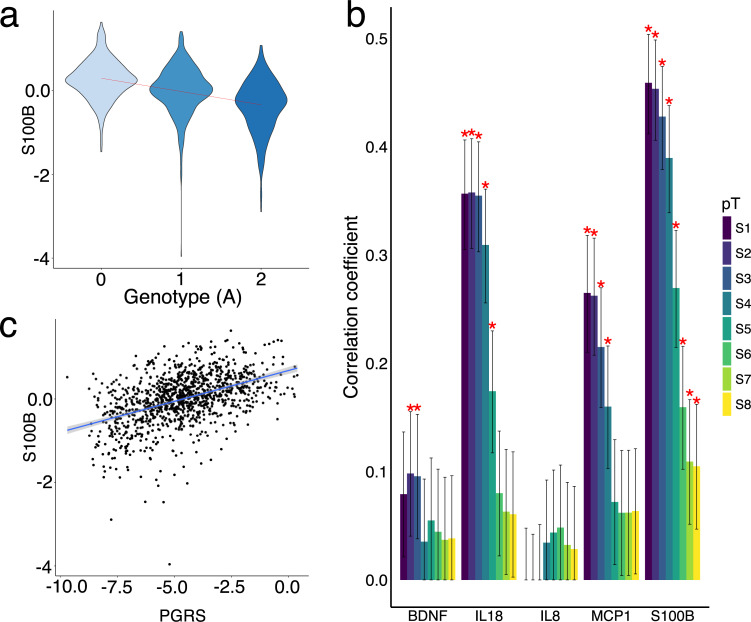
Prediction of inflammation marker levels by genetic variants.a. The distribution of the normalized S100B level in the replication sample is shown in the three genotype groups of rs62224256 (0: AA, 1, AG and 2 GG). A simple linear regression line(red) is added in the figure to show the trend. b. The Pearson’s correlation coefficients between polygenic scores and normalized S100B level in the replication sample are stratified by different p value threshold(pT) of association in the discovery sample (S1, P<1x10-6; S2, P<1x10-5; S3, P<1x10-4; S4, P <0.001; S5, P< 0.01; S6, P< 0.1; S7, P<0.5; S8, P<1.0). Standard errors are show by the error bar. Stars indicate significant correlations (P<0.00125 = 0.05/40). c. A scatter plot shows the predicted S100B level (normalized, fitted strait line) in the replication sample by SNPs with P<1x10-6 in the discovery sample.